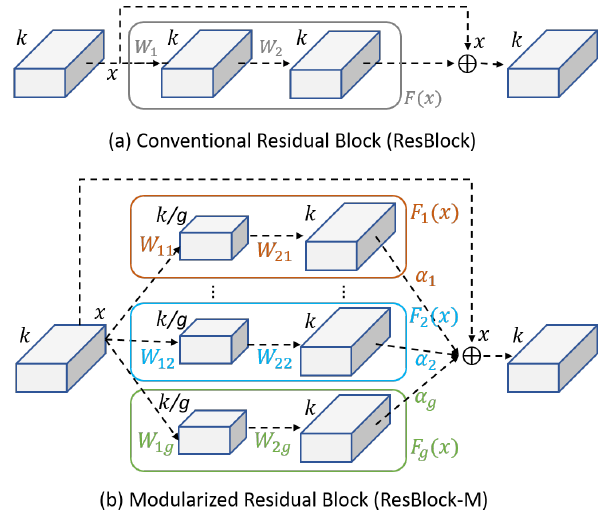
Figure 3. ( a ) The conventional residual block (ResBlock) contains a single building block with its function F ( · ) , and the output is F ( x ) + x . ( b ) Our modularized residual block (ResBlock-M) contains g disjointed building blocks (represented by different colors) with their corresponding functions F 1 ( · ) , F 2 ( · ) ,..., F g ( · ) . The output is α 1 F 1 ( x ) + α 2 F 2 ( x ) + · · · + α g F g ( x ) + x , where α i ∈ { 0,1 } determines the usage of F i ( · ) (best viewed in